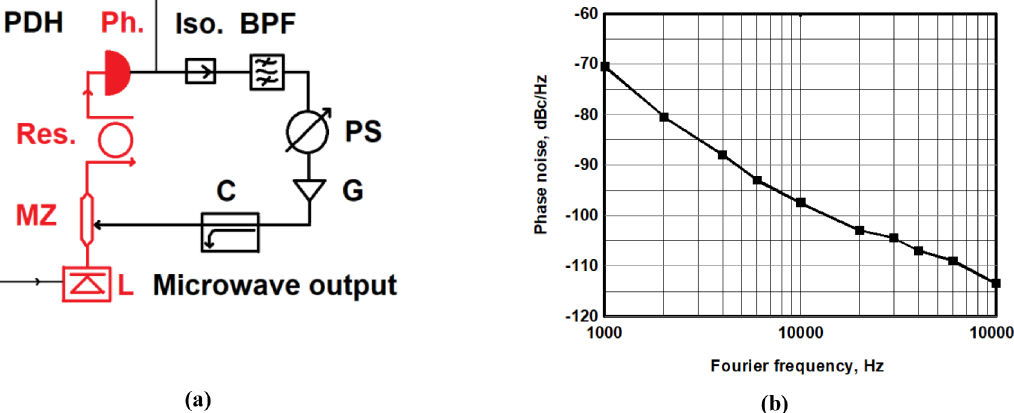
Figure 3. Optoelectronic oscillator schematized and its performances in terms of phase noise. (a) Optical elements and electrical elements are respectively drawn in red and black colours. L: laser, MZ: Mach Zehnder modulator, Res: optical resonator, Ph: photodetector, PDH: Pound Drever Hall, Iso: isolator, BPF: band pass fi lter, PS: phase shifter, G: microwave low noise ampli fi er, C: coupler. (b) Phase noise performance of an OEO based on an